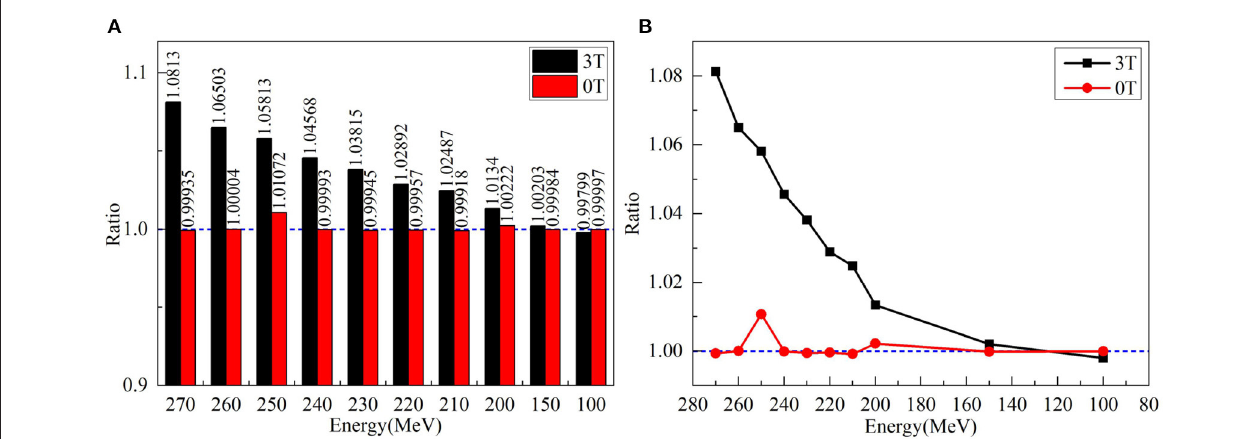
FIGURE 6 | Shows three sizes of isodose curves for 150 MeV protons over three dose levels under a 3.0 Tesla field strength with (A) and without a magnetic field (B) . The center point of each plot indicates the maximum dose at Bragg-peak position of each simulation. Each isodose curve was fit for a minimized area between the inscribed IC and EC circumscribed circles as described in the text to obtain the radii of IC and EC . When E